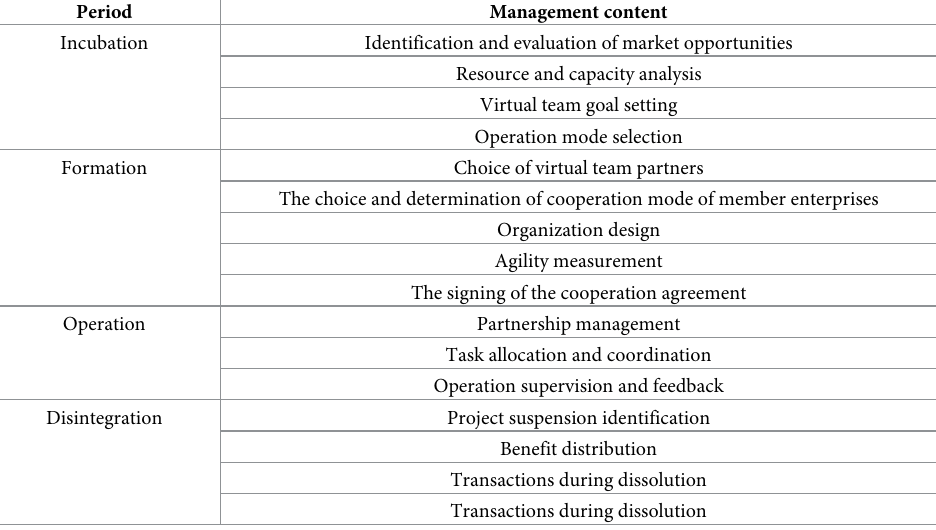
Table 1. Specific management content of each period of the virtual